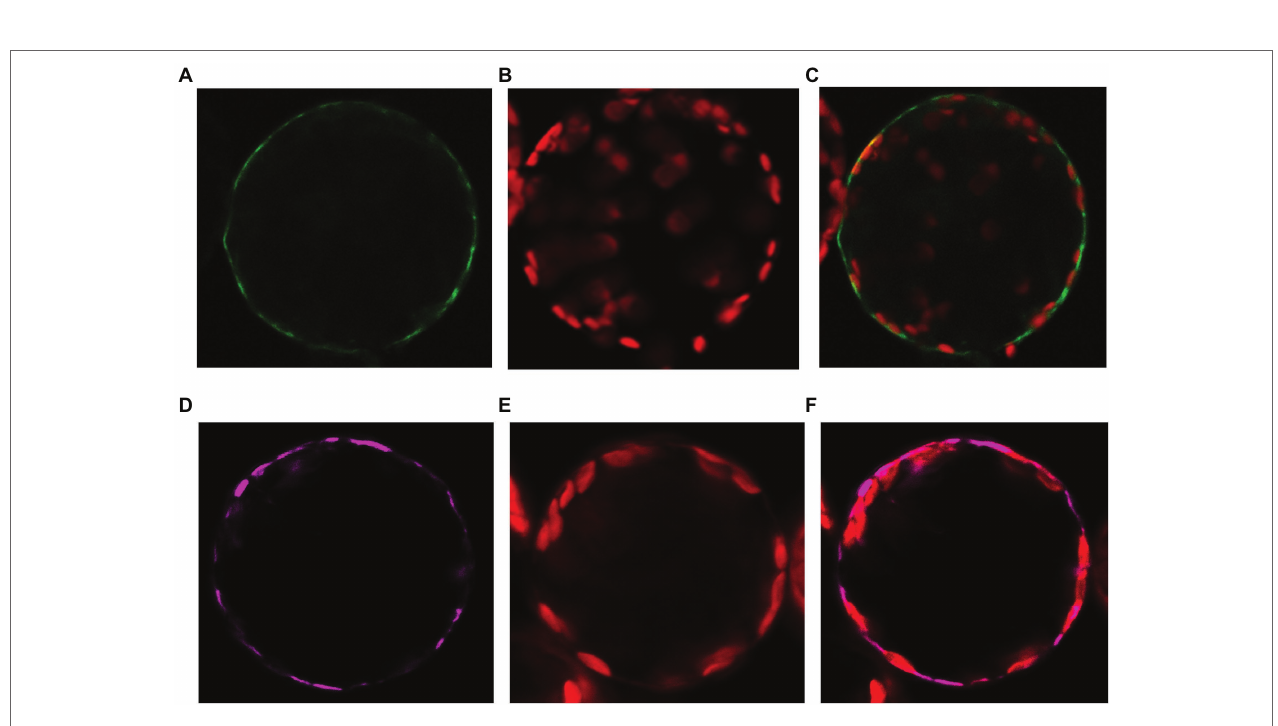
FIGURE 3 | Plasma membrane localization of the p35S-LjNPF3.1-eYFP fusion transiently expressed in protoplasts of tobacco mesophyll cells. (A) Plasma membrane localization of the 35S-LjNPF3.1-eYFP. (B) Chlorophyll autofluorescence of the transformed protoplast. (C) Merged image of (A,B) . (D) Plasma membrane localization of the pUBI-AtPIP2A-mCherry marker (purple). (E) Chlorophyll autofluorescence of the transformed protoplast. (F) Merged image of (C,D)